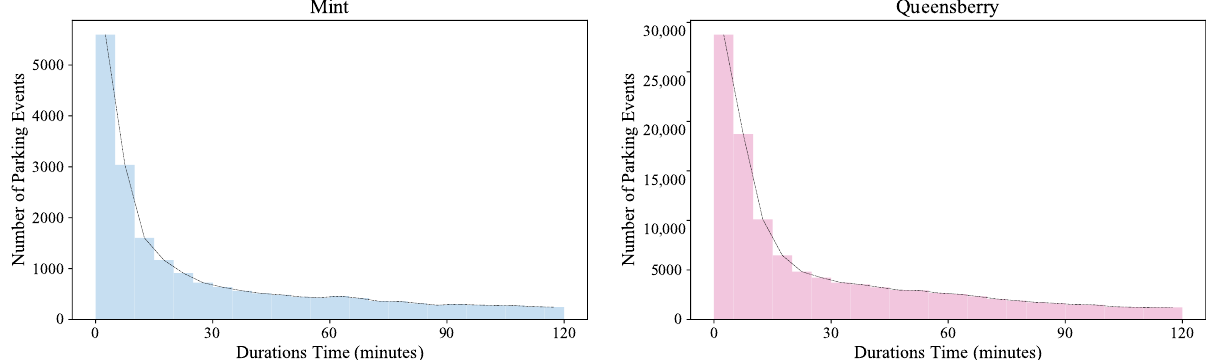
Figure 1. The distributions of the parking durations in two different areas (Mint and Queensberry) in Melbourne in July